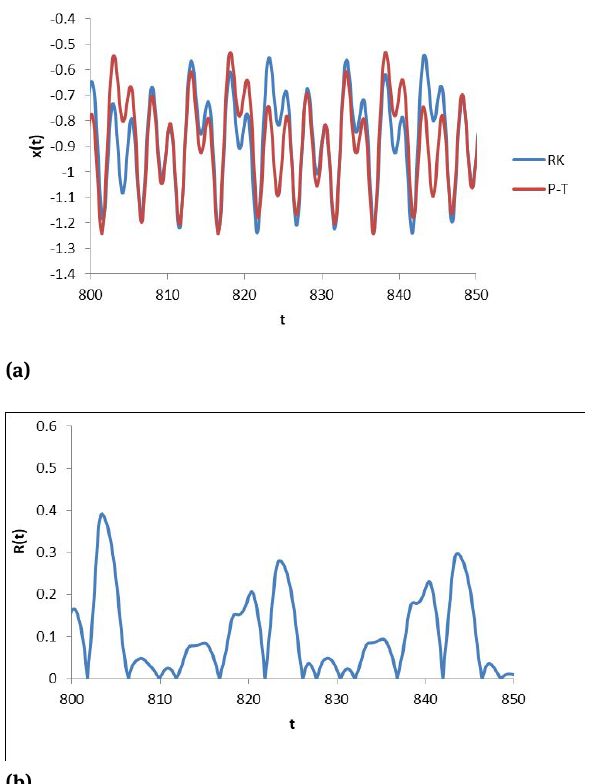
Figure 2: a) Numerical results of P-T and Runge-Kutta method ( dt = 0.005, r =0.935, ω =2.5, k =0.5, x (0) =-1.0, ˙ x (0) =-1.0); b) Numerical comparison of P-T and Runge-Kutta method (= 0.005, r =0.935, ω =2.5, k =0.5, x (0) =-1.0, ˙ x (0)